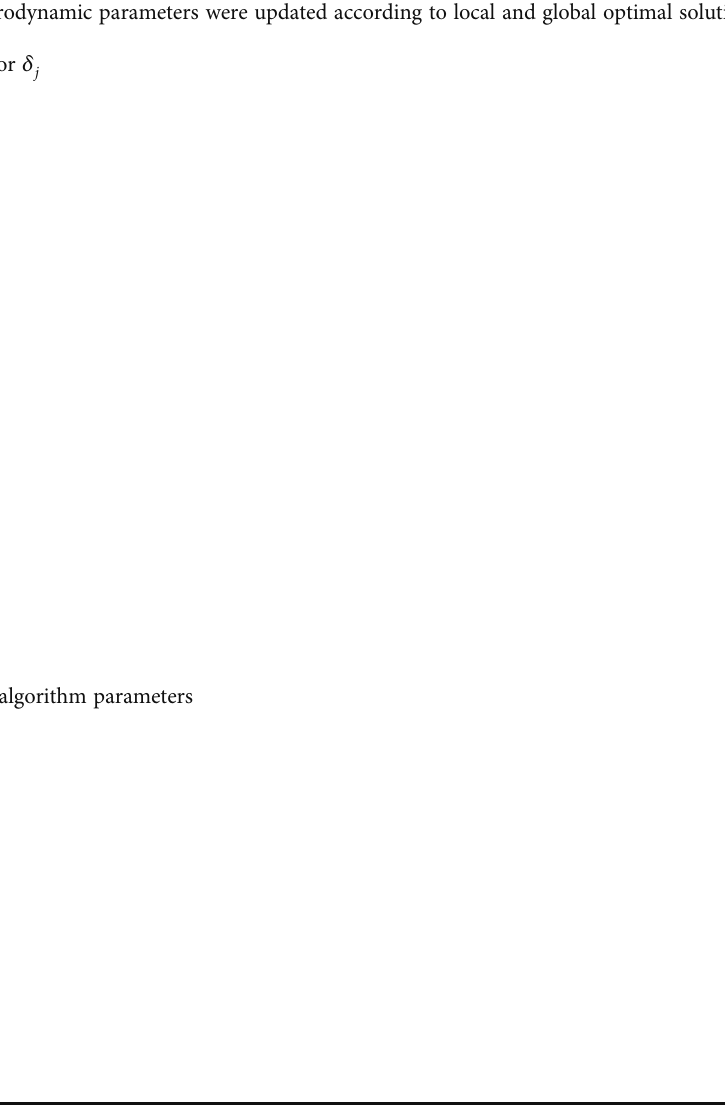
Algorithm 1: The main process the homology